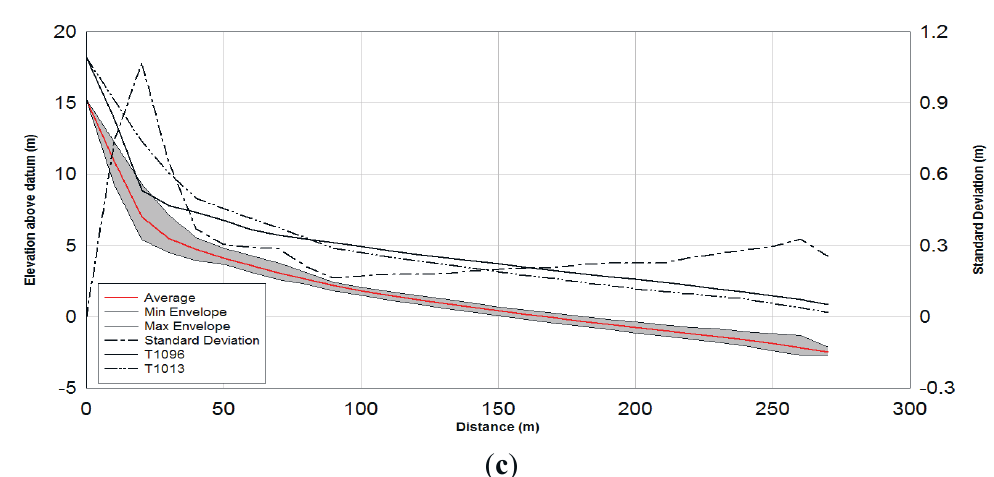
Figure 3. Cross shore profile envelopes, and standard deviations for the period 1996–2013, along with the first (1996) and last (2013) cross shore profiles offset by 3 m for clarity: ( a ) Transect 09; ( b ) Transect 10; and ( c ) Transect 11.